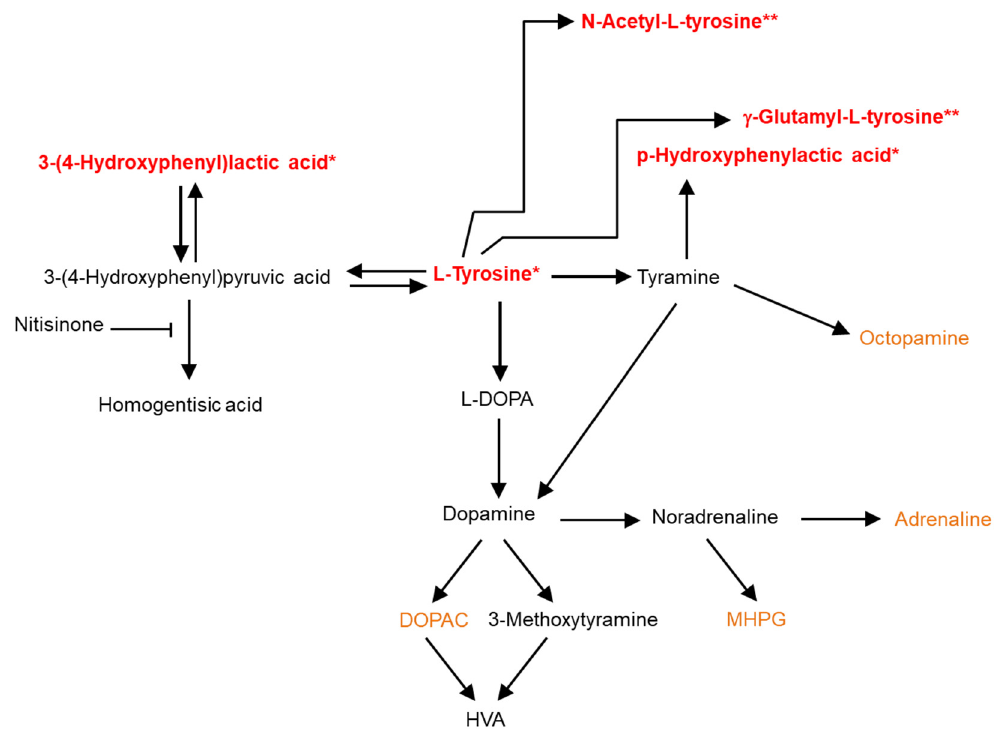
Figure 4. Summary of metabolite differences that were observed between Hgd − / − mice that received no treatment and Hgd − / − mice that received treatment with nitisinone. Red—compounds that had a higher abundance in CSF from mice treated with nitisinone; orange—metabolites matched in CSF samples, but abundances were not significantly different between the two groups of mice; black— compounds not matched in samples. *—log2 FC > 2.0, p < 0.05; **—log2 FC > 2.0, p > 0.05. HVA— homovanillic acid; DOPAC—dihydroxyphenylacetic acid; L-DOPA—L-3,4-dihydroxyphenylalanine; MHPG—3 ‐ methoxy ‐ 4 ‐ hydroxyphenylglycol.